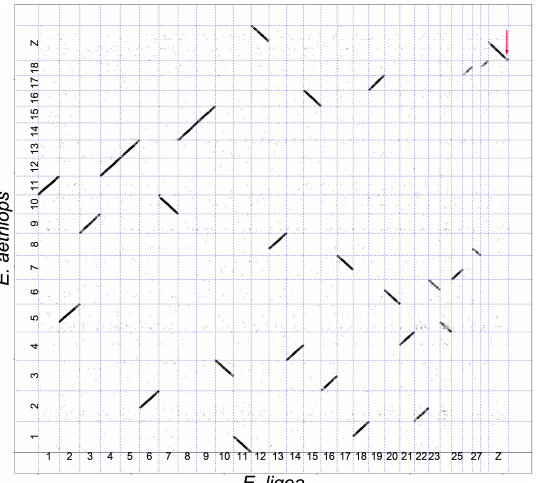
Figure 3. Genome of E. ligea (horizontal axis) plotted against genome of E. aethiops (vertical axis). It can be seen that chromosome 1 ligea corresponds to chromosome 11 aetiops , chromosomes 2 + 24 ligea correspond to chromosome 5 aethiops , chromosome 3 ligea corresponds to chromosome 9 aethiops , chromo- some 4 ligea corresponds to chromosome 12 aethiops , and so on, and chromosomes 12 + Z ligea correspond to chromosome neo-Z aethiops . Each short stroke represents a single syntenic block (a supported align- ment), positioned according to its position in the genomes of the compared species. The red arrow indicates a small terminal inversion in the Z